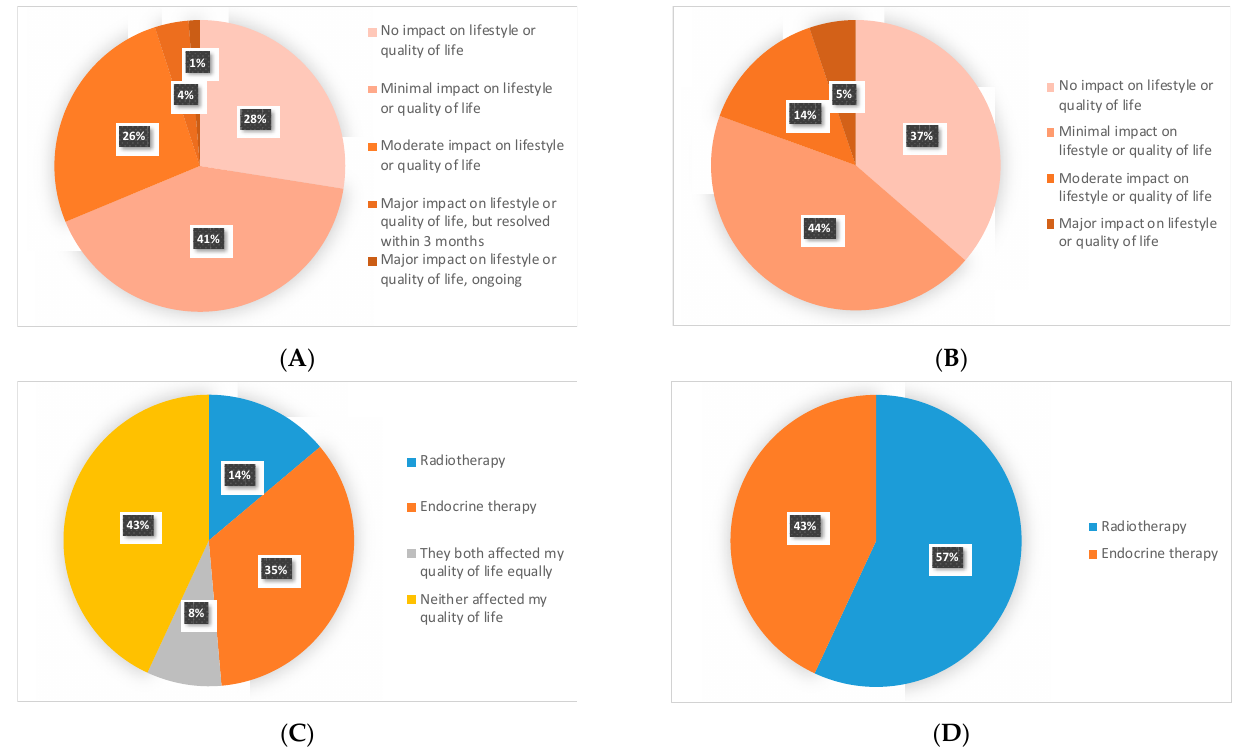
Figure 1. Radiotherapy versus endocrine therapy’s impact on quality of life and preferences: ( A ) impact of radiotherapy on quality of life/lifestyle; ( B ) impact of endocrine therapy on quality of life/lifestyle; ( C ) which treatment affects your quality of life the most?; ( D ) which treatment would you rather receive?